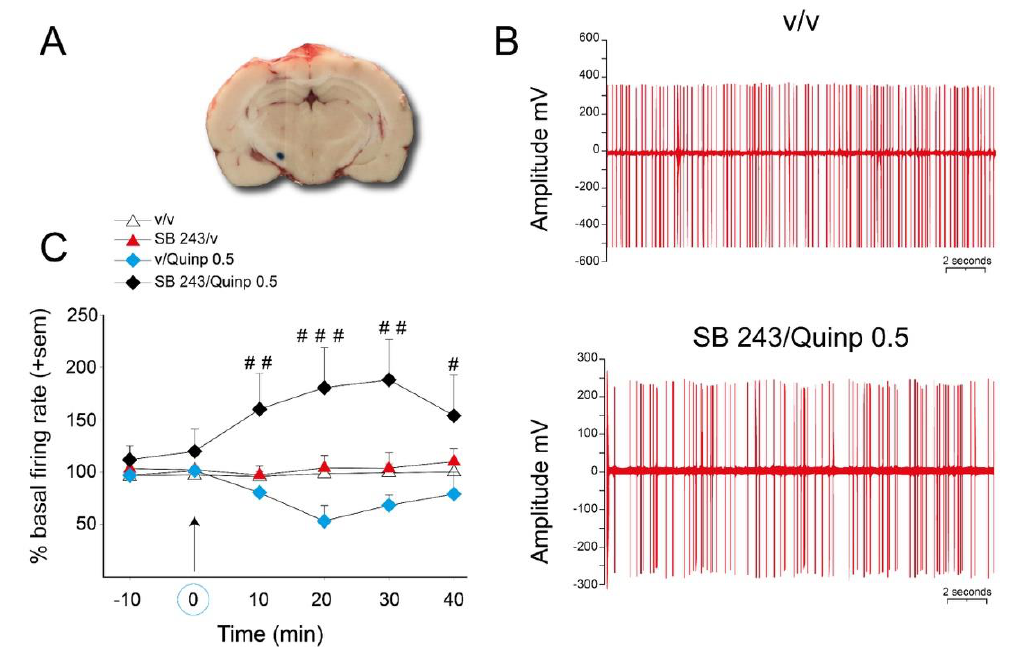
Figure 5. E ff ect of SB 243213 and quinpirole on the activity of STN neuron activity. ( A ) photomicrograph showing one electrode placement in the STN (blue dot). ( B ) electrophysiological recording of STN neurons receiving saline or the combination of quinpirole and SB243213. Instead of regular discharge, STN neurons receiving the combination of the drugs fired irregularly. ( C ) e ff ect of quinpirole on the discharge frequency of SNr neurons pretreated by SB 243213 (1 mg / kg) or its vehicle. Quinpirole 0.5 mg / kg was injected 60 min after SB 243213 (correspondingly marked on the x-axis and by the arrows). The values indicate the percentage of the basal frequency of discharge ± S.E.M. measured during 40 min after the i.p. injection of quinpirole or its vehicle. # p < 0.05, ## p < 0.01, and ### p < 0.001, Fisher’s PLSD test after significant two-way ANOVA performed on each time point.